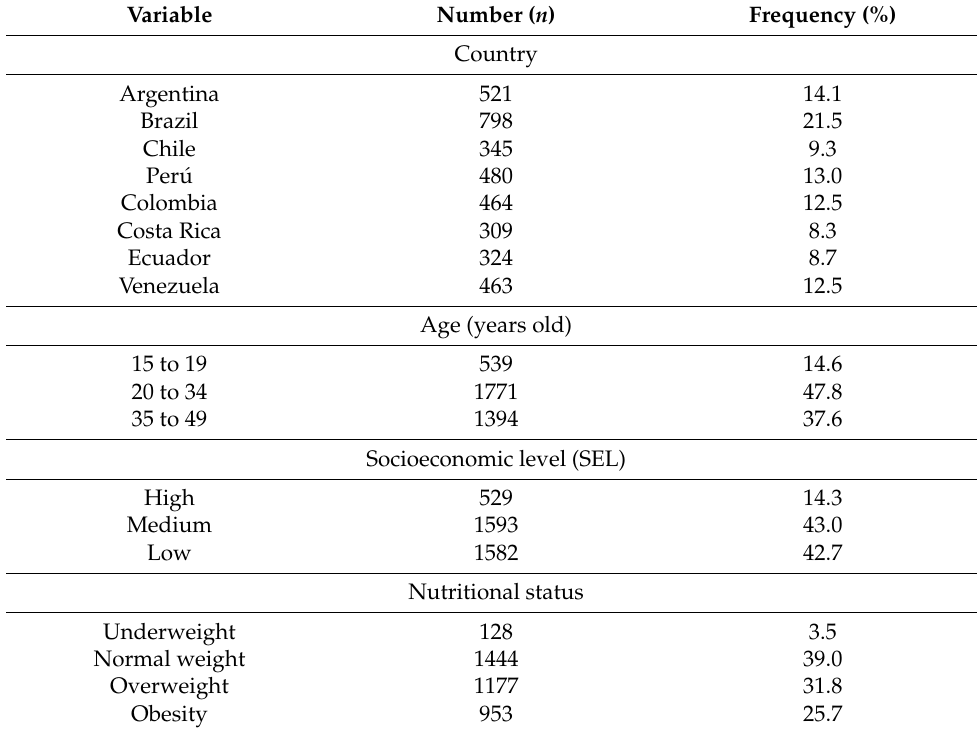
Table 1. Sample characteristics: distribution of 3704 15–49-year-old WRA participants of ELANS in different countries and sociodemographic